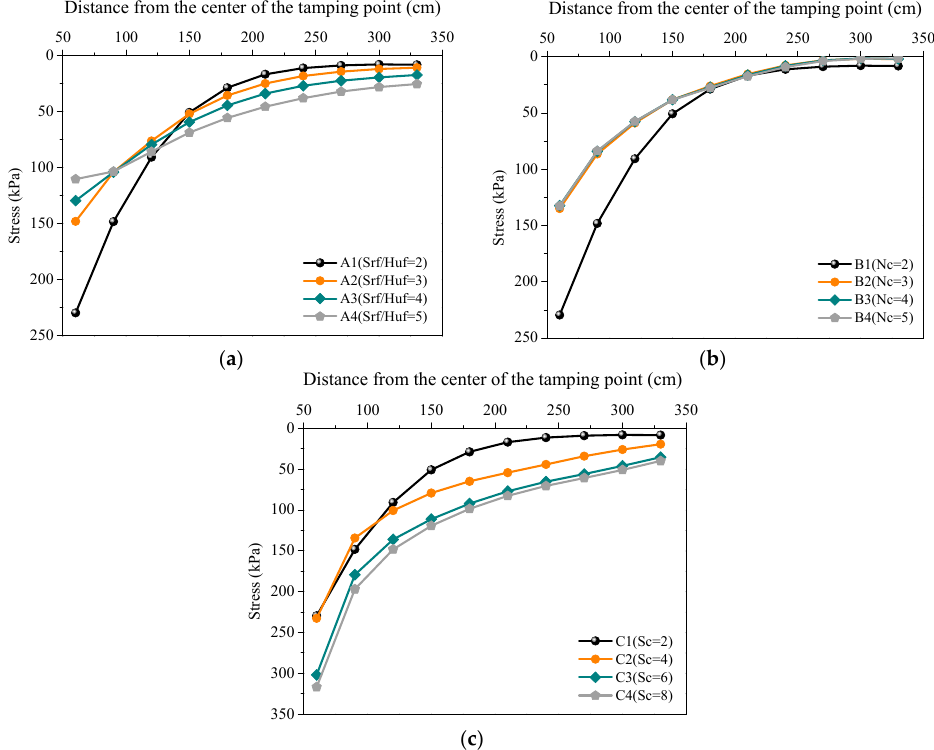
Figure 9. Stress of reinforced geogrids under different reinforced factors: ( a ) embedded ratio; ( b ) number of reinforced layers; ( c ) interval of reinforced layers.